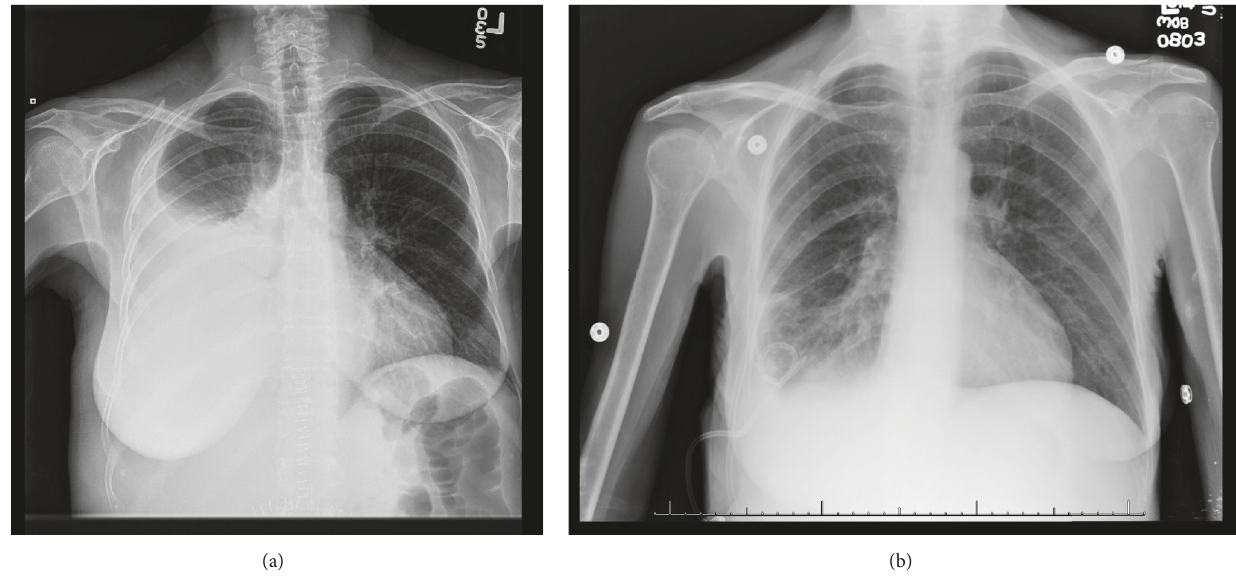
Figure 2: (a) Large right pleural effusion with significant right lung atelectasis and (b) subsequent Improvement of Right pleural effusion after pigtail placement.